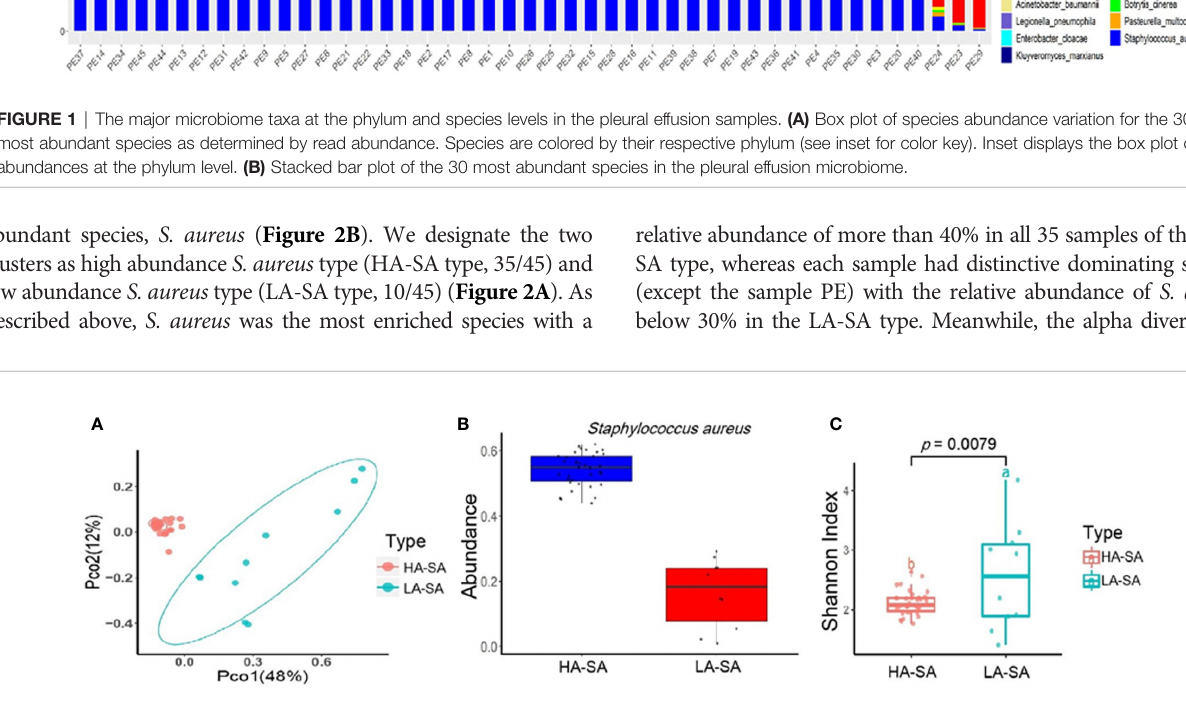
FIGURE 2 | Microbiome composition of the HA-SA and LA-SA type samples. (A) Principal Coordinate Analysis. Species among the microbial community for each sample is generated based on the Bray-Curtis similarity matrix in HA- and LA-SA type. The fi rst two components (PCo1 and PCo2) of the PCoA plot explained 48% and 12% variations, respectively, in two groups, with a wider range of within-group distribution in the LA-SA group. (B) The abundance levels of the main contributing species of two microbiome types. (C) Alpha diversity estimation. Signi fi cant differences in Shannon diversity estimates of microbial communities on species level in HA- and LA-SA